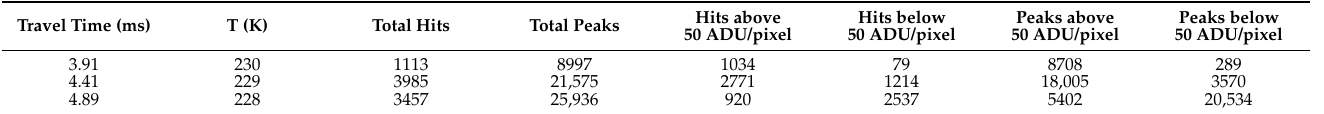
Figure 6. Different classes of peaks: ( a ) circular peaks that are peaks with one local maximum, a sphericity higher than 0.7 and ∆ Q cm of at least 0.2 Å − 1 to the nearest peak in reciprocal space; ( b ) non-circular peaks that are peaks with one local maximum, a sphericity lower than 0.3 and ∆ Q cm of at least 0.2 Å − 1 to the nearest peak in reciprocal space; and ( c ) structured peaks that have several maxima or single peaks that have ∆ Q cm of less than 0.2 Å − 1 to the nearest peak. All peaks are shown from 0 to 5000 ADU in a non-perceptual (jet) colormap. Table 1. Hit and peak statistics for different temperatures (or different travel distances of the droplet from nozzle tip to the interaction region).